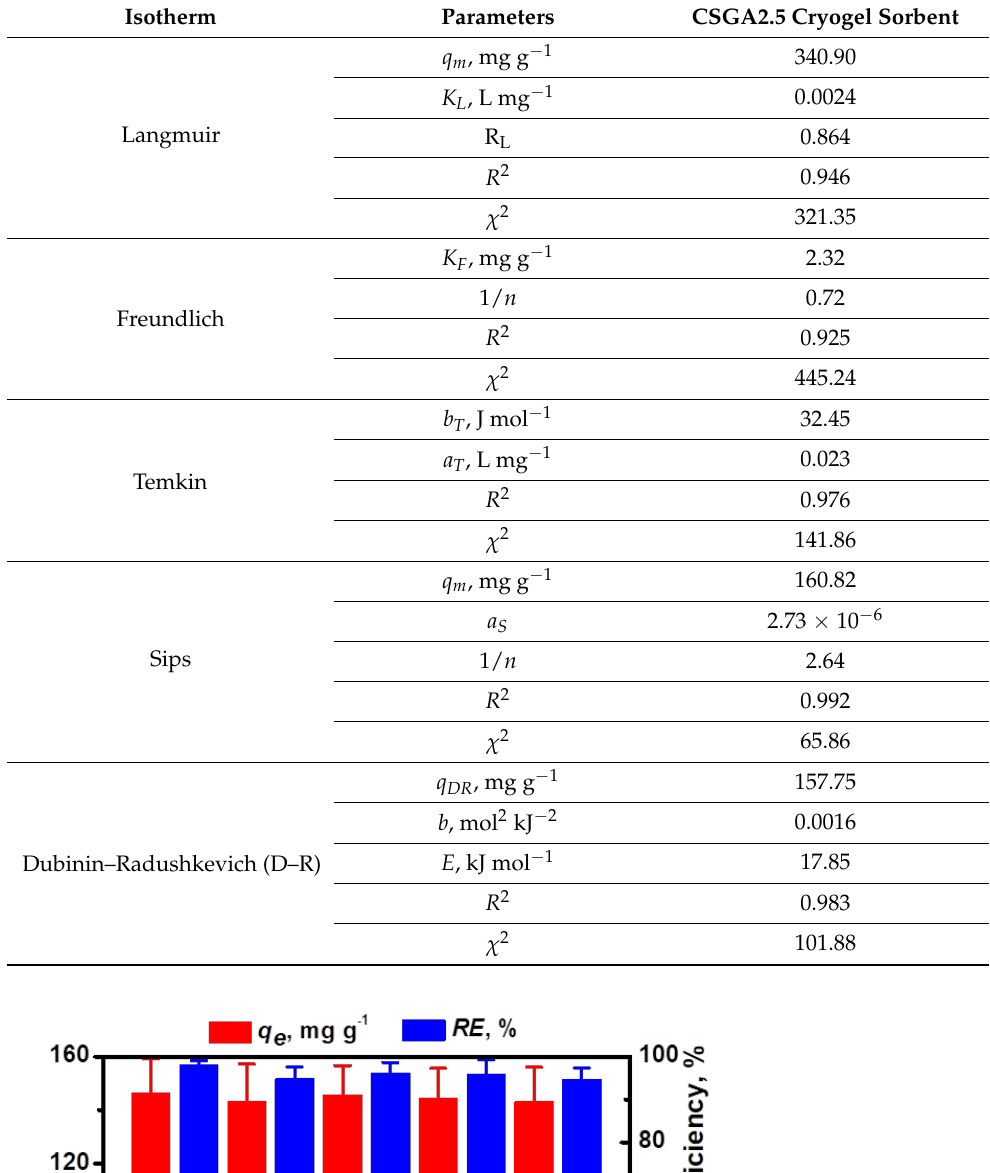
Table 3. Isotherm parameters and coefficients of determination for the adsorption of Fastac 10EC by a CSGA2.5 cryogel sorbent.